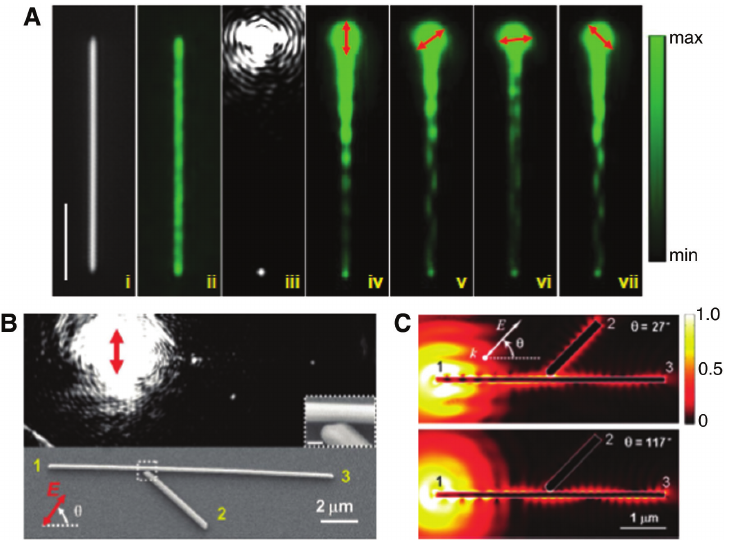
Figure 6: (A) PSPs in a silver NW excited by laser light of 633 nm wavelength [74]. (i) Optical image of a Ag NW. (ii) QD fluorescence image with wide field excitation. (iii) Scattering image showing excitation of PSPs. (iv–vii) QD fluorescence images for different polarizations of incident laser. The scale bar is 5 μ m. The red arrows indicate the incident laser polarization. (B) Optical image of a silver nanobranch excited by laser light of 633 nm wavelength and SEM image of the structure [75]. The red arrow represents the incident polarization. The inset is the SEM image of the junction, where the scale bar is 200 nm. (C) Simulated electric field |E| distributions for the maximum (top) and minimum (bottom) emission at the branch wire [75]. Reproduced with permission from Refs. [74] and [75]. Copyright 2011 American Chemical Society (Ref. [74]), and Copyright 2010 American Chemical Society (Ref.